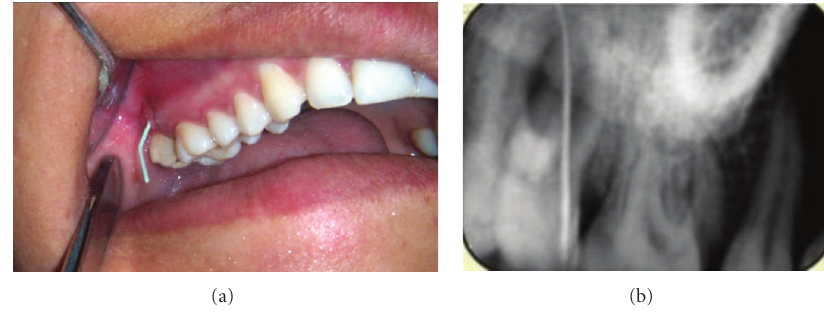
Figure 2: Clinical and radiographic tracing of sinus.